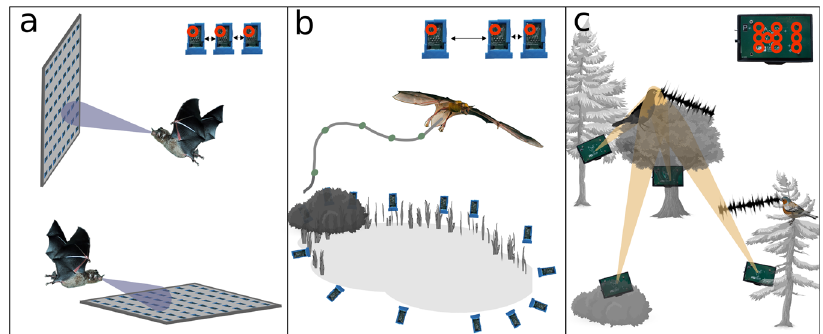
Fig. 2 Examples of array architectures and potential functions. a Two 64-microphone arrays of single microphone units (Fig. 1b) with equal spacing (see inlay at the top) to investigate beamforming and scanning behavior in gleaning bats. Below for bats that glean from the ground like Antrozous or some Myotis species, above for vegetation gleaners like Micronycteris or nectar feeding bats. (credits bat image Ralph Simon). b Sparse microphone array with single microphone units arranged around a body of water to study echolocation behavior of trawling bats. The fl ight path of the bat can be reconstructed by analyzing the TDoA of the echolocation calls at the individual microphones. Microphones can be distributed over longer distances and have variable spacing as indicated above. (credits bat image MerlinTuttle.org). c Distributed small-scale arrays arranged in a forested area to localize and track vocalizing birds. Each unit has ten microphones as indicated with red circles on the inlay at the top. The orange beam or cone is a 3D representation of the probabilistic AoA of the sound at the small-scale array. (credits tree and bird images